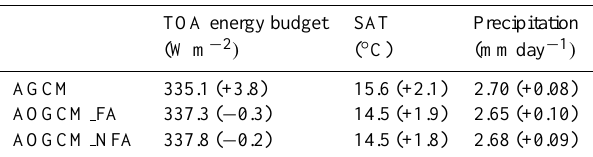
Table 4. Pliocene global annual mean values and anomaly from the Control (parentheses). Energy budgets at the top of the atmosphere (TOA) are calculated as a sum of shortwave and longwave, down- ward minus